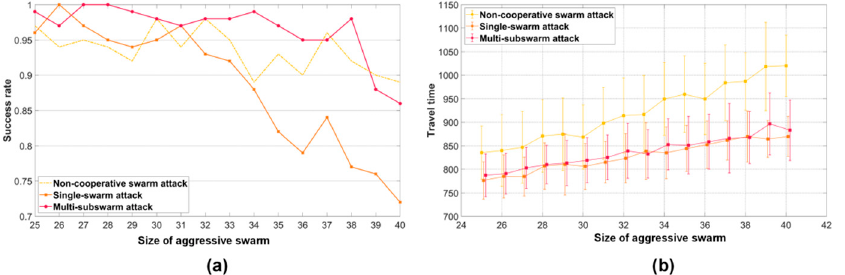
Figure 7. Escort performance (100 independent runs) comparison under different swarm attack pat ‐ terns. ( a ) Comparison on success rate. ( b ) Comparison on travel time of HVU.